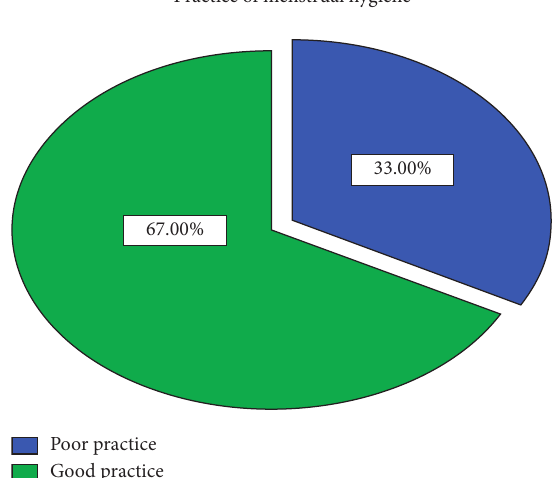
Figure 1: Distribution of adolescent school girls’ practice grading on menstruation